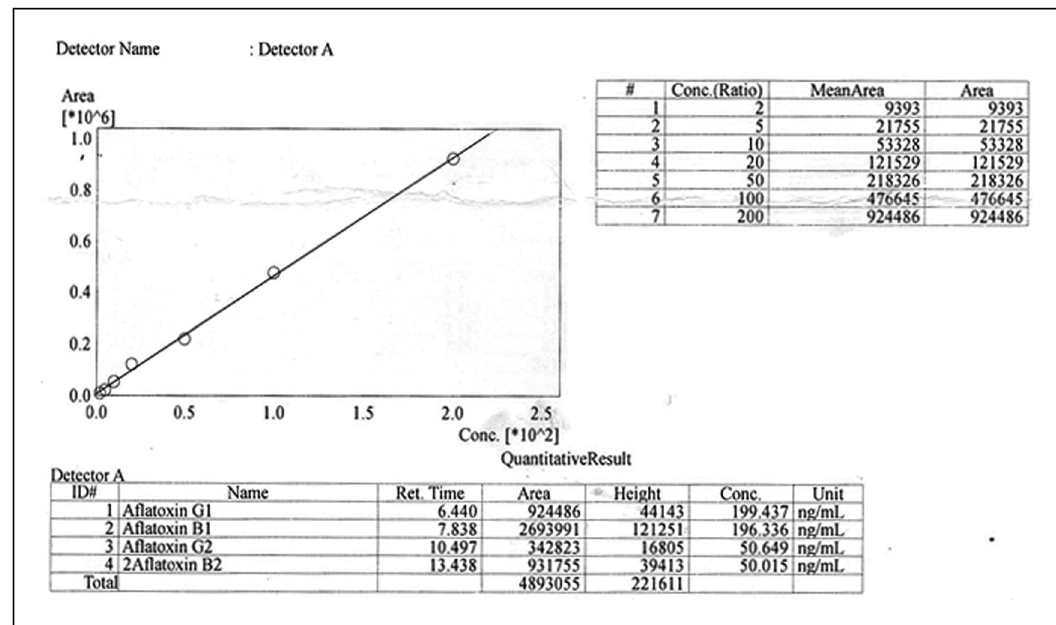
Figure 3: Calibration curve for a fl atoxin B 1